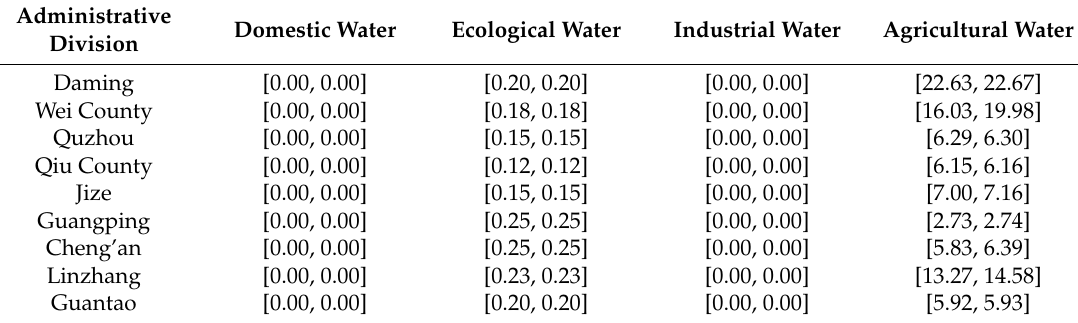
Table 6. Result of recycled water allocated to every user (10 6 m 3 ).